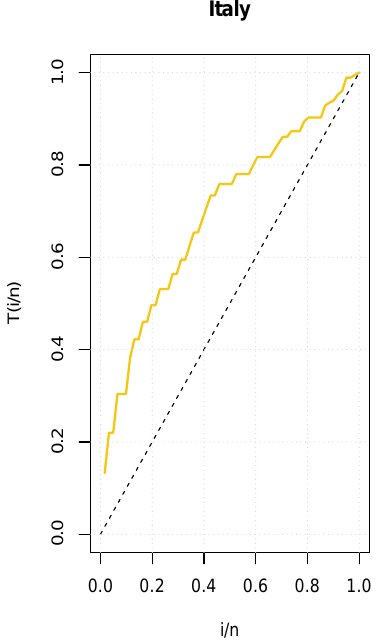
Figure 3. Total Time on Test (TTT) plot for the COVID-19 data set of